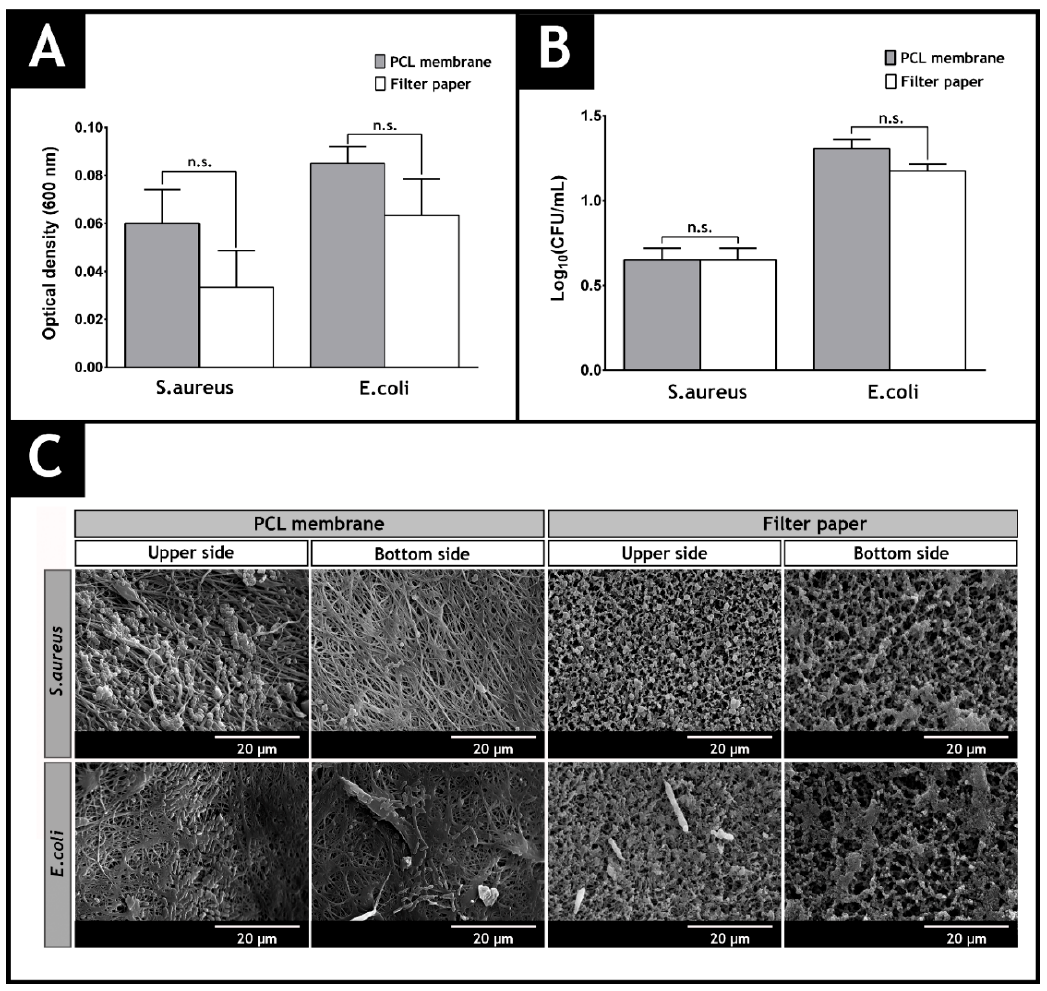
Figure 9. Evaluation of the bacterial infiltration through PCL membrane and filter paper (control group). The optical density of the medium culture present in the lower chamber of the transwell system determined at 600 nm is shown in ( A ); The number of colony forming units of S. aureus and E. coli that cross the PCL and filter paper, after 24 h, are displayed in ( B ); SEM images of adhered microorganisms ( S. aureus and E. coli ) at the upper and lower side of the PCL membrane and filter paper are observed in ( C ).